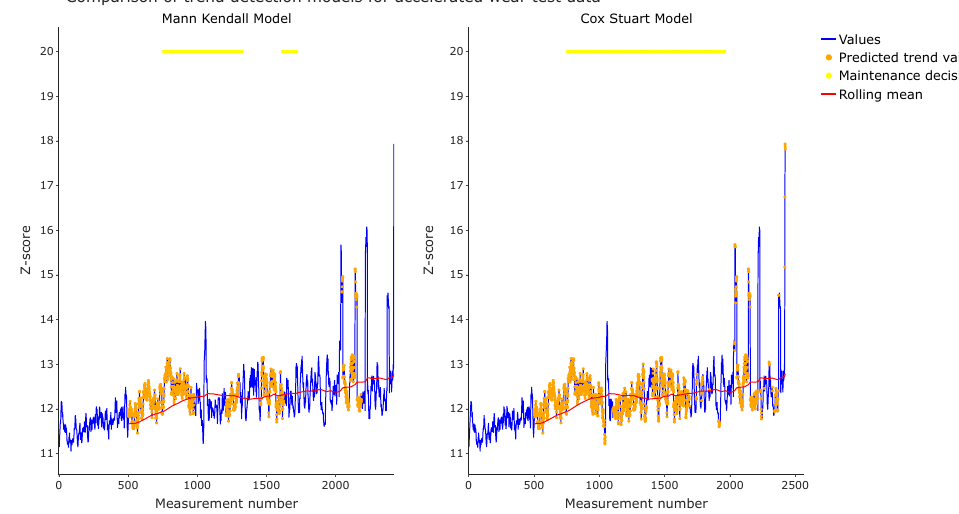
Figure 9. Results of the trend detection models based on accelerated wear test